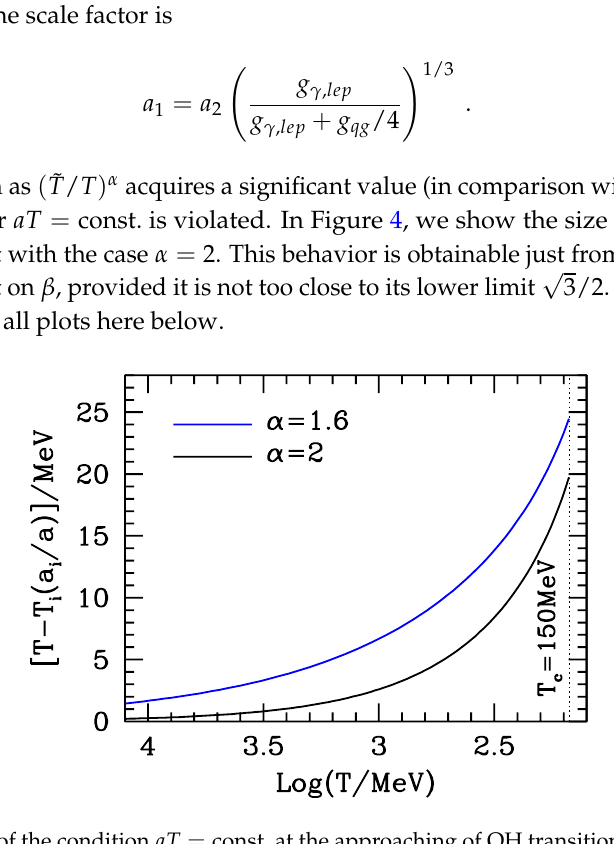
Figure 4. Violation of the condition aT = const. at the approaching of QH transition. T i ( a i ) is any large temperature (small scale factor) where asymptotic freedom still holds.